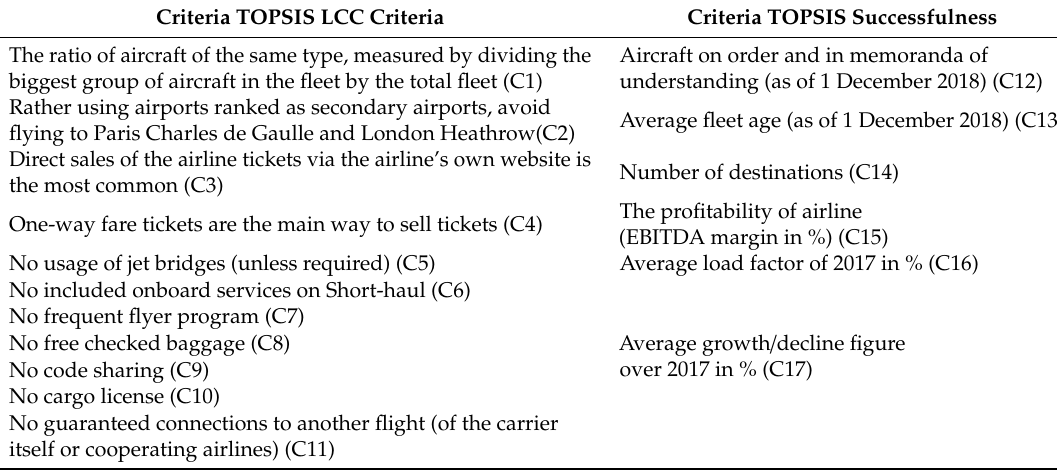
Table 1. Criteria for TOPSIS